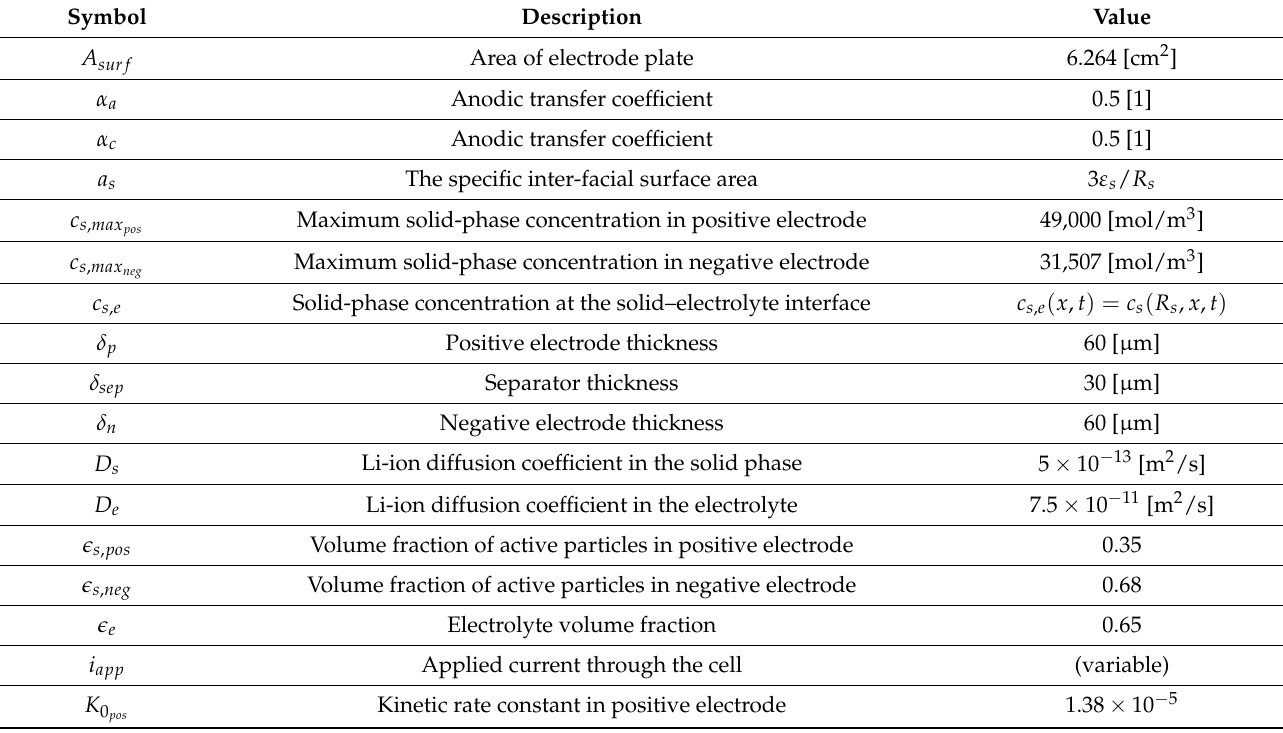
Table 3. Key parameters and their values used in the DFN model of the cell